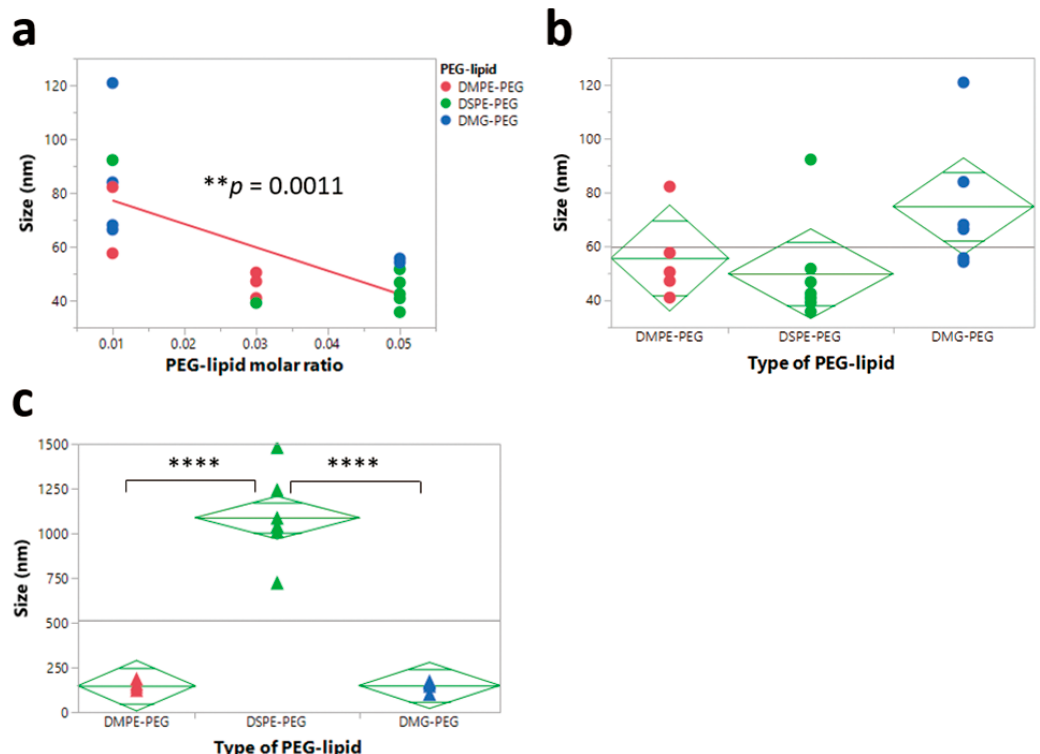
Figure 5. Correlation between particle size and poly-(ethylene) glycol (PEG)-lipid. ( a ) Effects of PEG-lipid molar ratio on particle size before nebulization. ( b ) Effects of type of PEG-lipid on particle size before nebulization. ( c ) Effects of type of PEG-lipid on particle size after nebulization. (** p < 0.01, **** p < 0.0001)